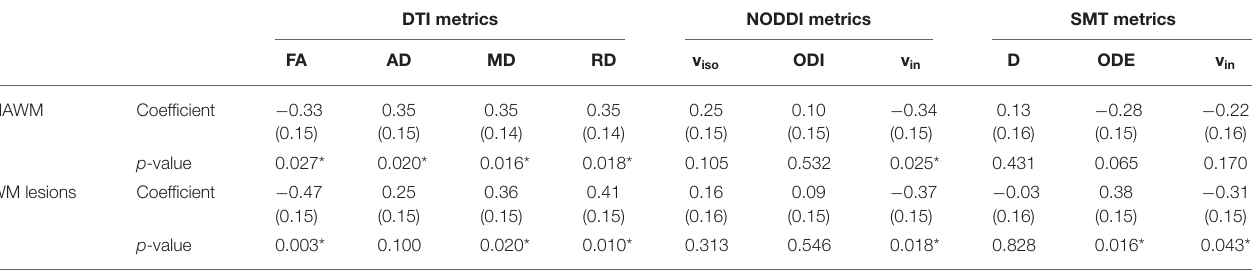
TABLE 2 | Association between EDSS and DTI, NODDI and SMT metrics as obtained from linear regression